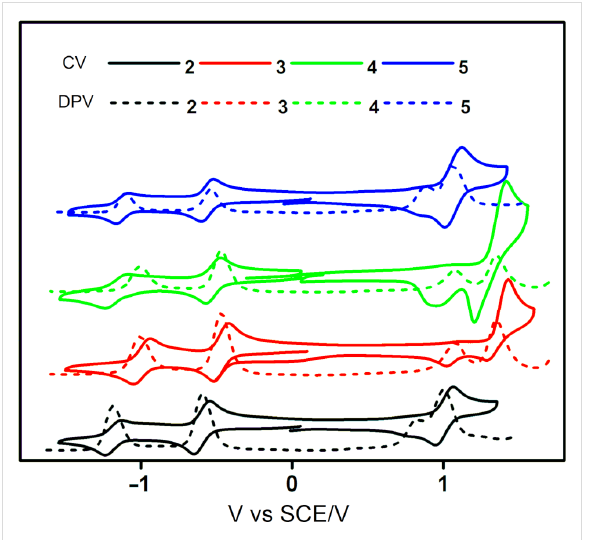
Figure 4: Cyclic voltammograms and differential pulse voltammo- grams of 2 – 5 in degassed DCM (scan rate = 100 mV·s − 1